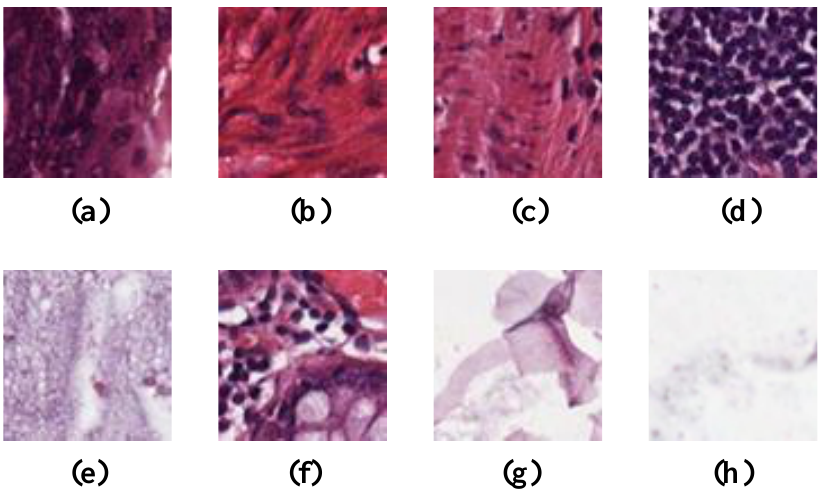
Figure 5. Example images of the eight tissue classes represented in the Kather-texture-2016-image- 5000 dataset. ( a – h ) defined in Section 3.2.2.